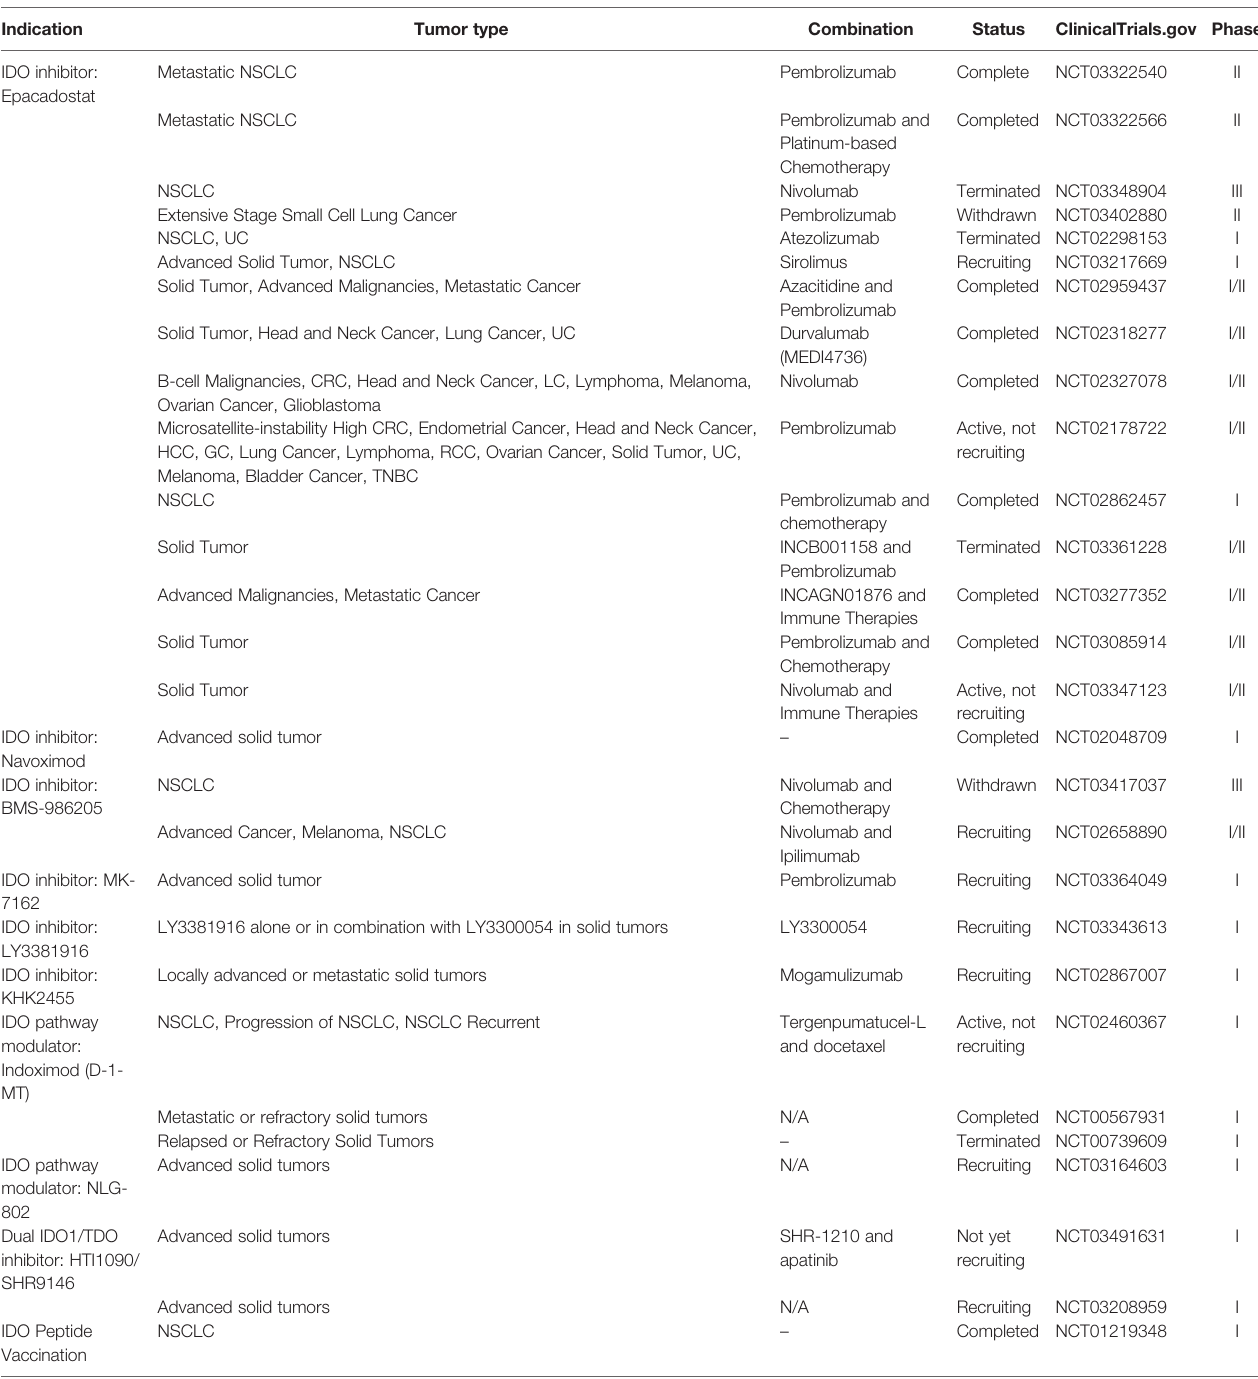
TABLE 1 | Clinical trials for the potential drugs targeting the IDO1/TDO-KYN pathway.